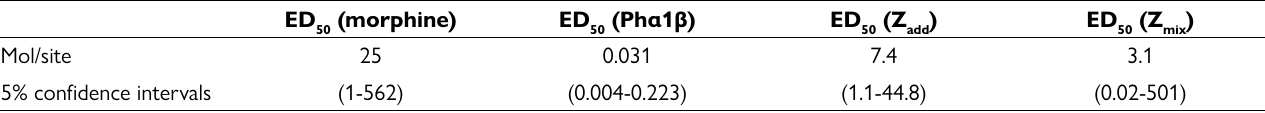
(50% antinociceptive doses) of the agents in melanoma-induced mechanical hypersensitivity. Table 1. ED 50